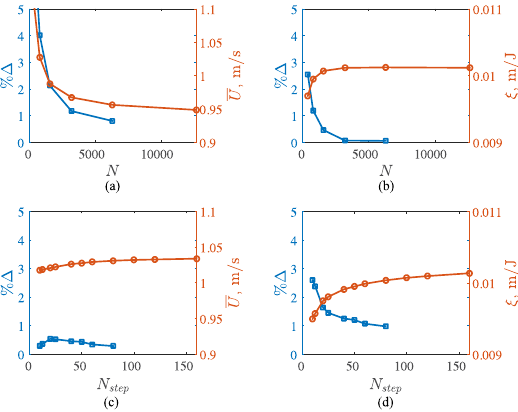
Figure 3. Left vertical axis is the percent change of a performance metric when the number of elements or time steps is doubled; Right vertical axis is the performance metric. ( a ) Cruise velocity convergence as the number of body elements is increased; ( b ) Economy convergence as the number of body elements is increased; ( c ) Cruise velocity convergence as the number of time steps is increased; ( d ) Economy convergence as the number of time steps is increased.